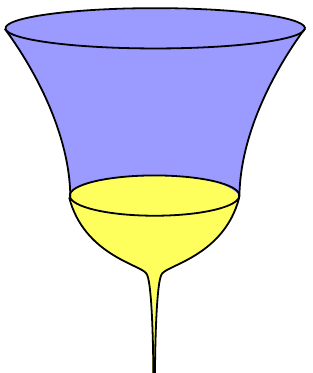
Figure 3. Euclidean and Lorentzian manifold with loop quantum cosmology (LQC)